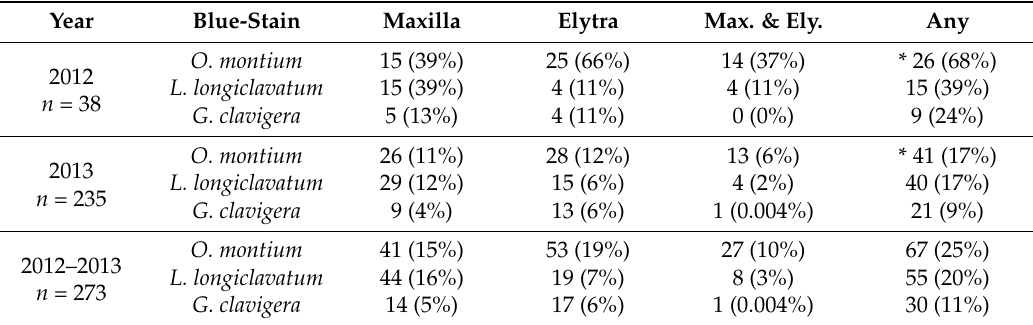
Table 2. Number and percent of beetles with presence of O. montium, L. longiclavatum, or G. clavigera in the maxillary mycangia, elytra, both structures, or either structure (columns) across and within years (rows). * indicates significance difference at the 0.05 level.